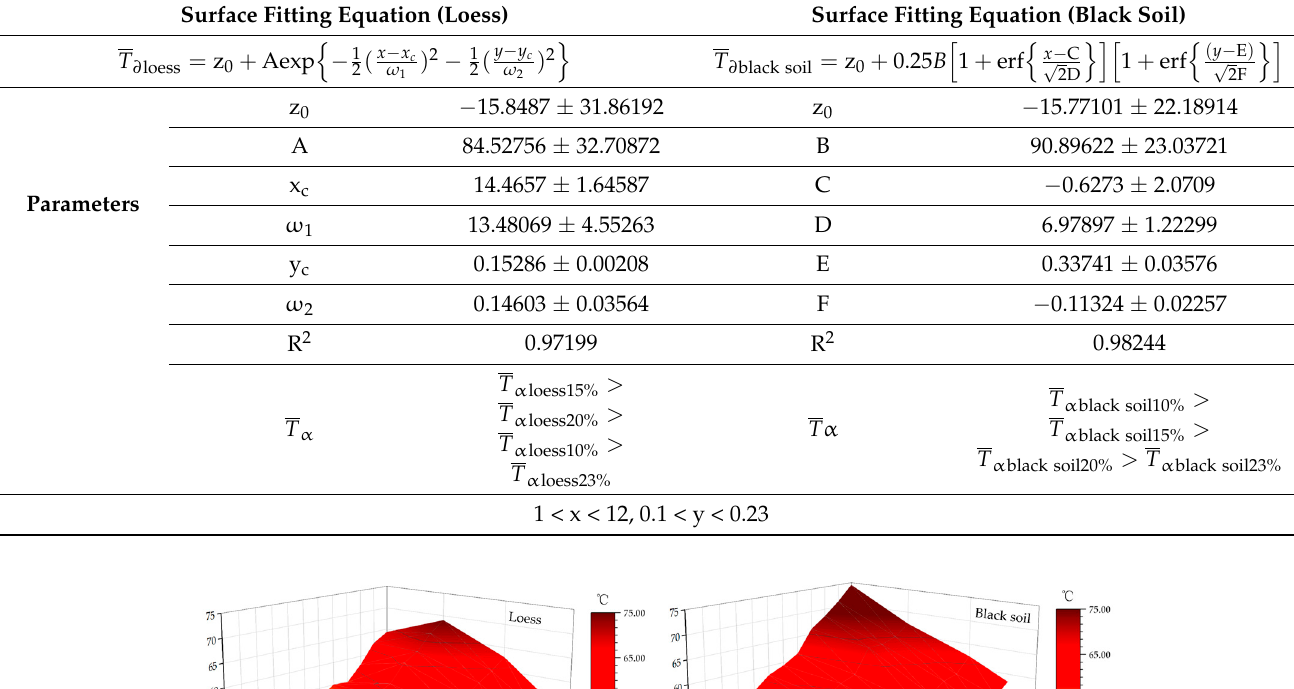
Table 5. Irradiation time–soil moisture content temperature surface equation.